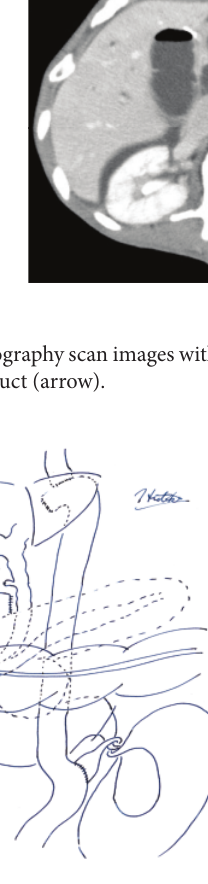
Figure 3: Schematic diagram of intraoperative findings. The patient previously underwent total gastrectomy and cholecystectomy. The afferent (biliopancreatic) limb was twisted 360